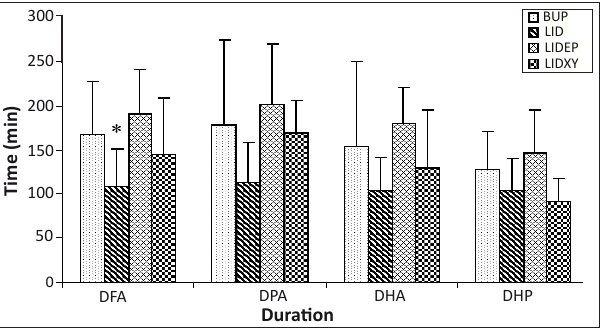
FIGURE 1: Duration of complete anaesthesia (mean ± s.d.) at the flank, perineum and hindlimb and duration of hindlimb paralysis after epidural administration of lidocaine, lidocaine-epinephrine, lidocaine-xylazine or bupivacaine in fat-tailed sheep ( n =